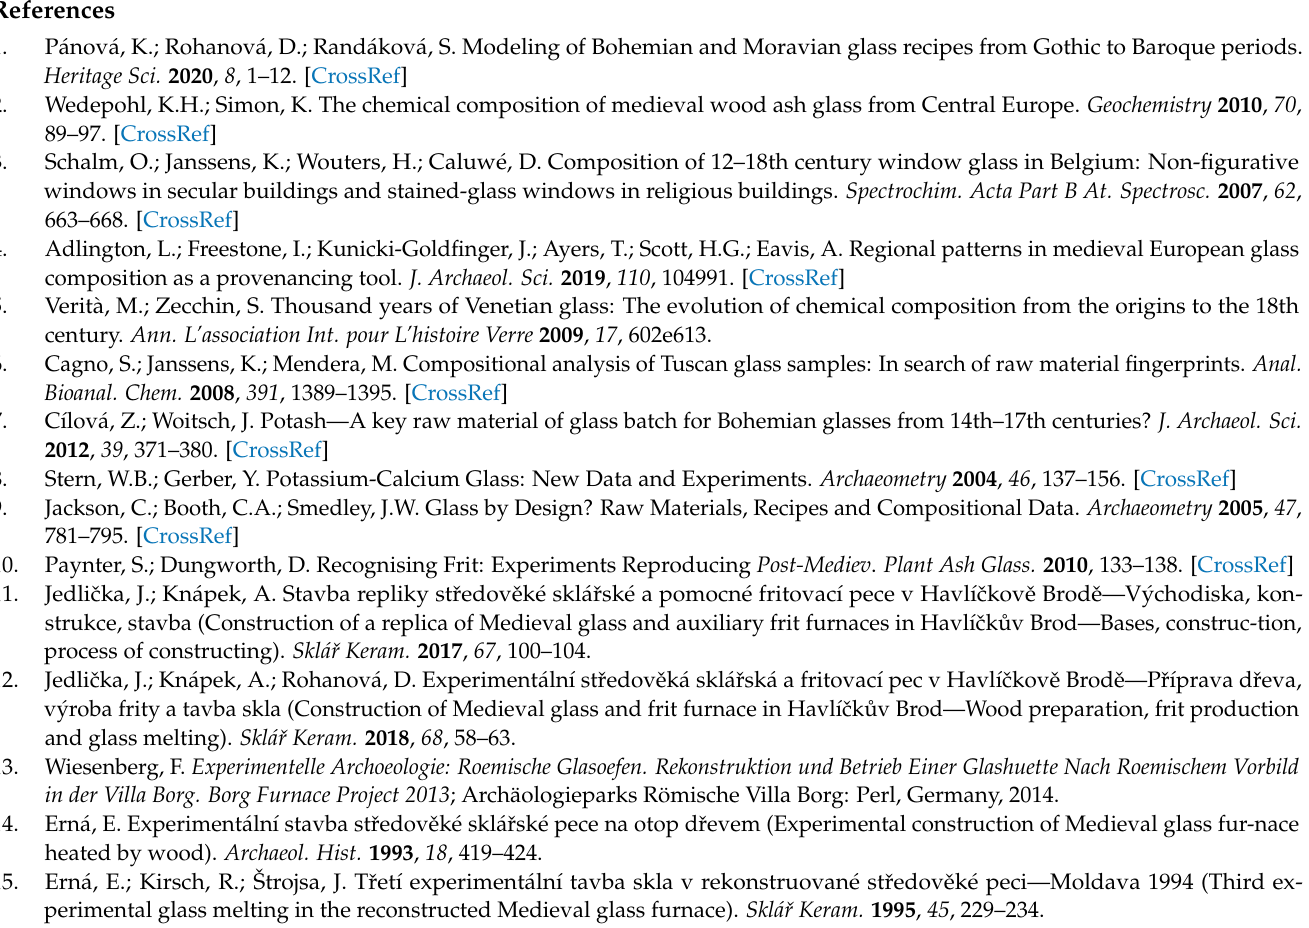
data for beech ash, Figure S4: XRD data for Gothic model glass, Figure S5: XRD data for Renaissance model glass, Figure S6: XRD data for Baroque model glass, Table S1: XRF analysis of raw materials, Table S2: Viscosity data obtained during the